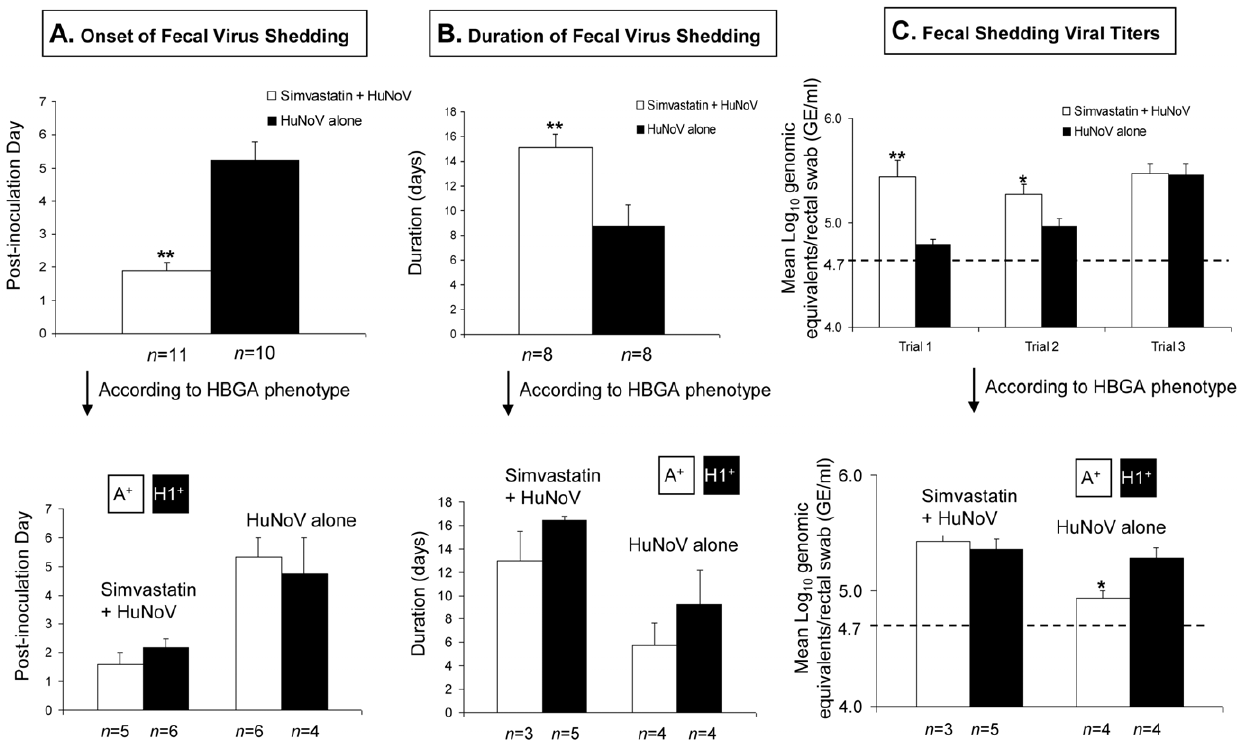
Figure 2. Simvastatin treatment induces significantly earlier onset and longer duration of virus shedding, frequently with higher viral titers in the feces, regardless of HBGA phenotype (A/H1) of the pigs. The mean onset and duration of fecal HuNoV shedding are summarized ( A, B ), and the daily viral titers (mean) as monitored by qRT-PCR are shown ( C ). Monitoring continued until 3 to 4 weeks after infection and terminated when PCR results were negative ( , 4.7 log 10 GE/ml) for 3 consecutive days. Data from 3 independent animal trials were combined, and the PCR test was performed in duplicate or triplicate. Additional analysis was also conducted according to the HBGA A or H1 phenotype of each animal. Each bar represents the mean 6 SEM. * P , 0.05; ** P , 0.01 for Simvastatin + HuNoV vs HuNoV alone or for A + pigs vs H + pigs by the unpaired two-tailed Mann-Whitney test. Animal numbers ( n ) are indicated at the bottom of each graph. The dotted line indicates the detection limit (4.7 log 10 GE/ml) of the